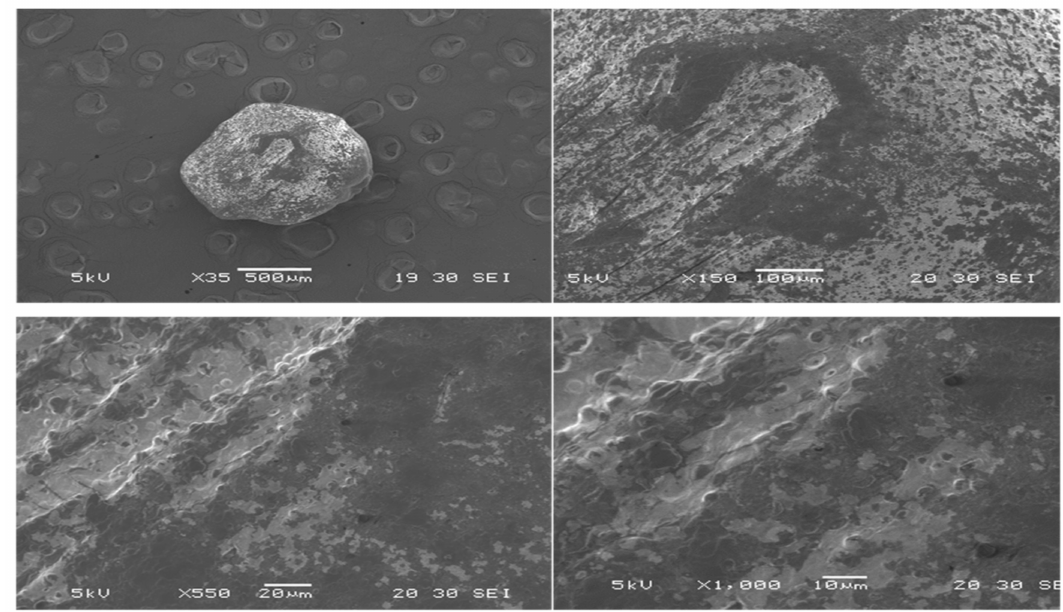
Figure 2. SEM analysis of CUR-MCT-KC bead showing spherical shape with moderately rough surface features. SEM analysis was performed at 5 kV over a magnification of × 35 to × 1000.